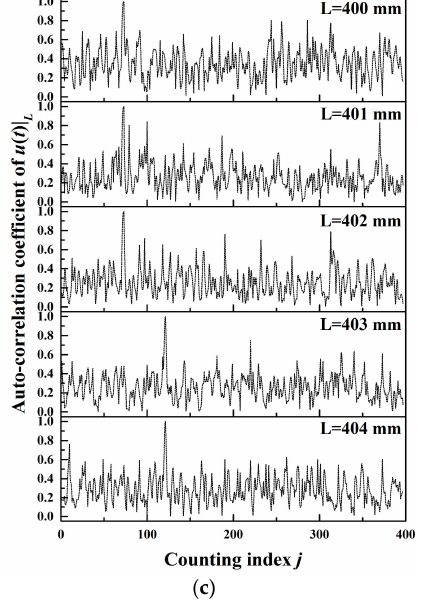
Figure 13. Uncertainty analysis results for the controlled response u ( t ) | 403 mm, 404 mm, 405 mm). ( a )—5 samples of the controlled response u ( t ) | u ( t ) | obtained by the Grey model, ( c )—auto-corelation coefficient of u ( t ) | L